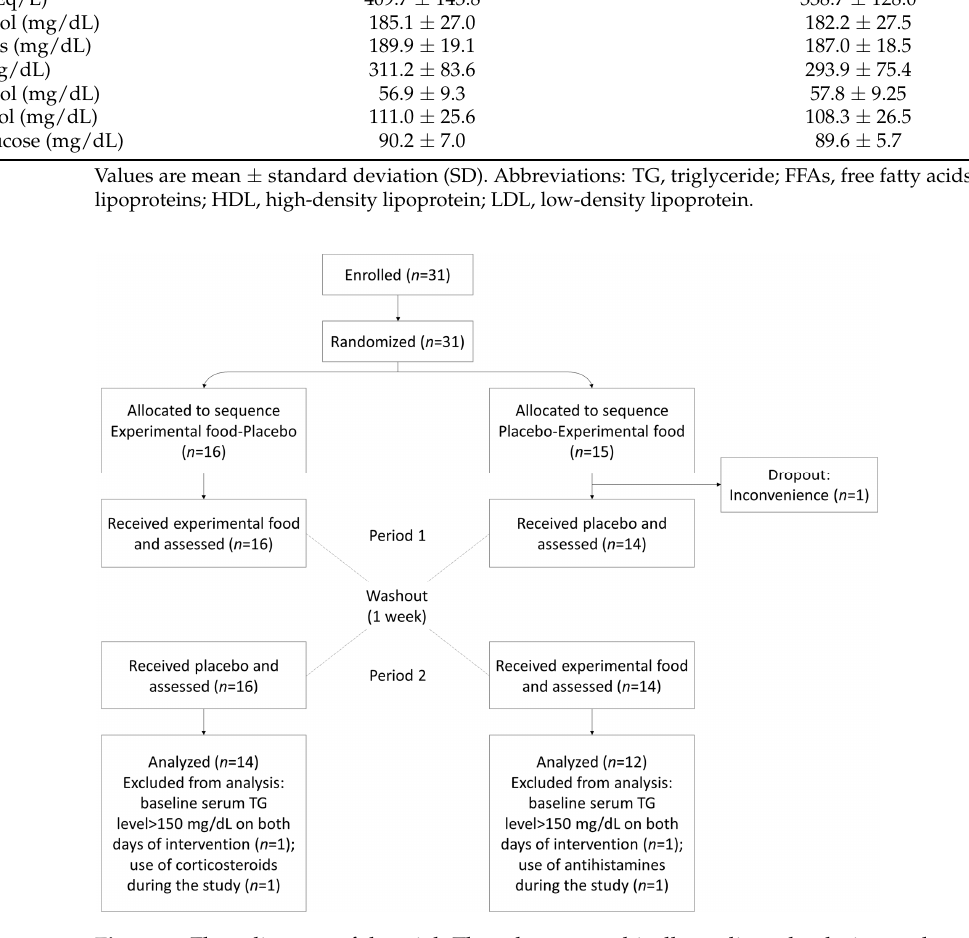
Figure 2. Flow diagram of the trial. The schema graphically outlines the design and conduct of the two-arm, two-period crossover trial. TG,